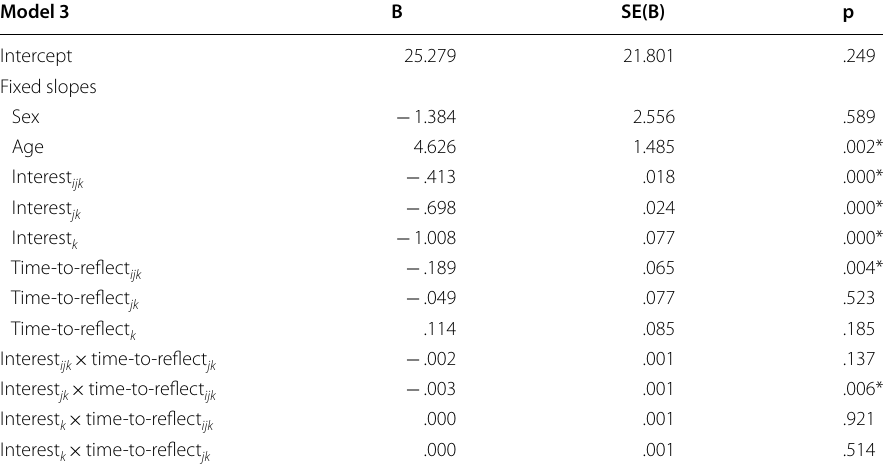
Table 5 Cross-level interactions of control and value